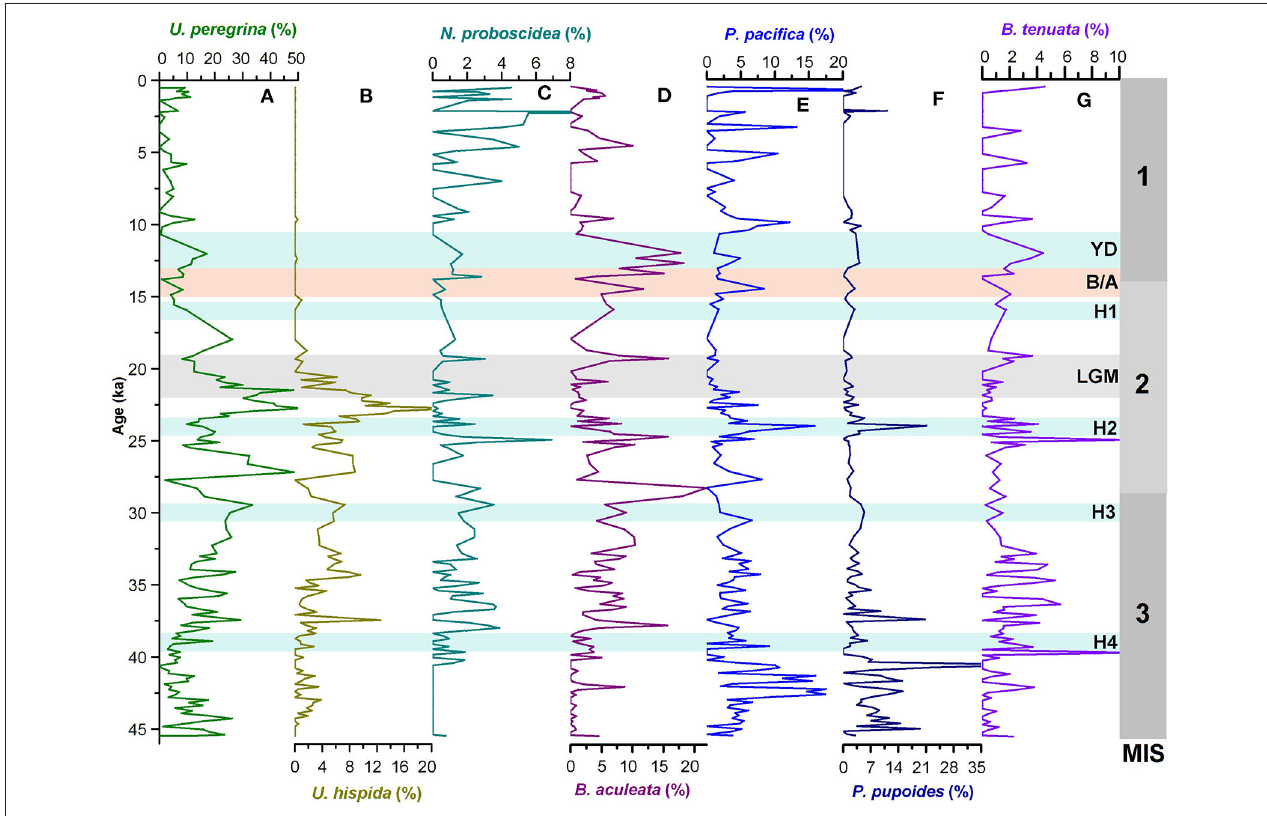
FIGURE 2 | Temporal variations in relative abundances of (A–C) uvigerinid species ( U. peregrina, U. hispida , and N. probscidea ) and (D–G) buliminid species ( B. aculeata, P. pacific, P. pupoides , and B. tenuata ) in the core SK 218/1. MIS 1–3 denotes the Marine Isotope Stages, H1–H4, Heinrich Events; YD, Younger Dryas; B/A, Bølling/Allerød; LGM, Last Glacial